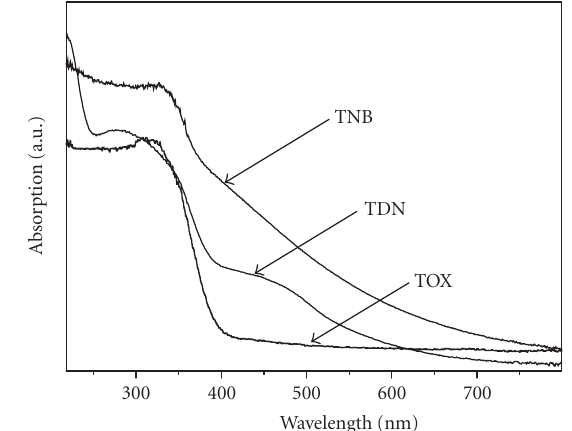
Figure 3: UV-Vis di ff use reflection absorption spectra of samples, TOX, TDN, and